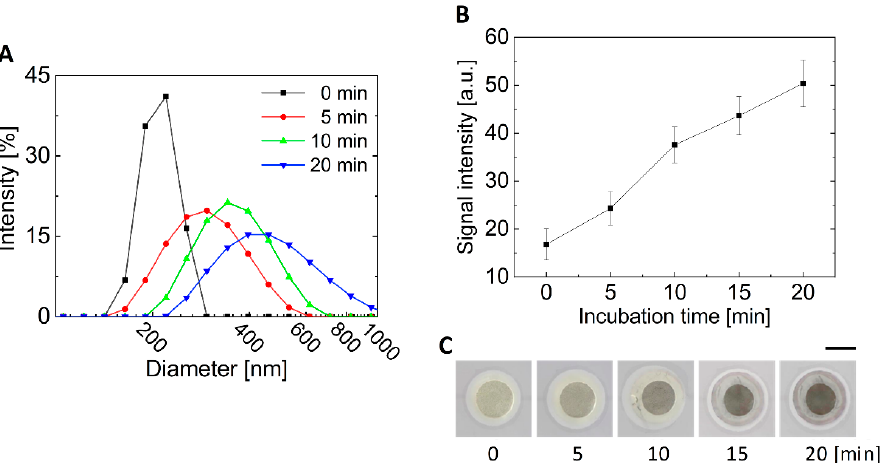
Figure 5. Effect of the gold enhancer on the colorimetric signal. (A) Size change of MNPs according to the incubation time in a gold enhancer solution. (B) Graph and (C) images showing the increasing colorimetric signal (negative control) in a finger-powered microfluidic device according to the incubation time with gold enhancer solution. Scale bar = 3 mm.